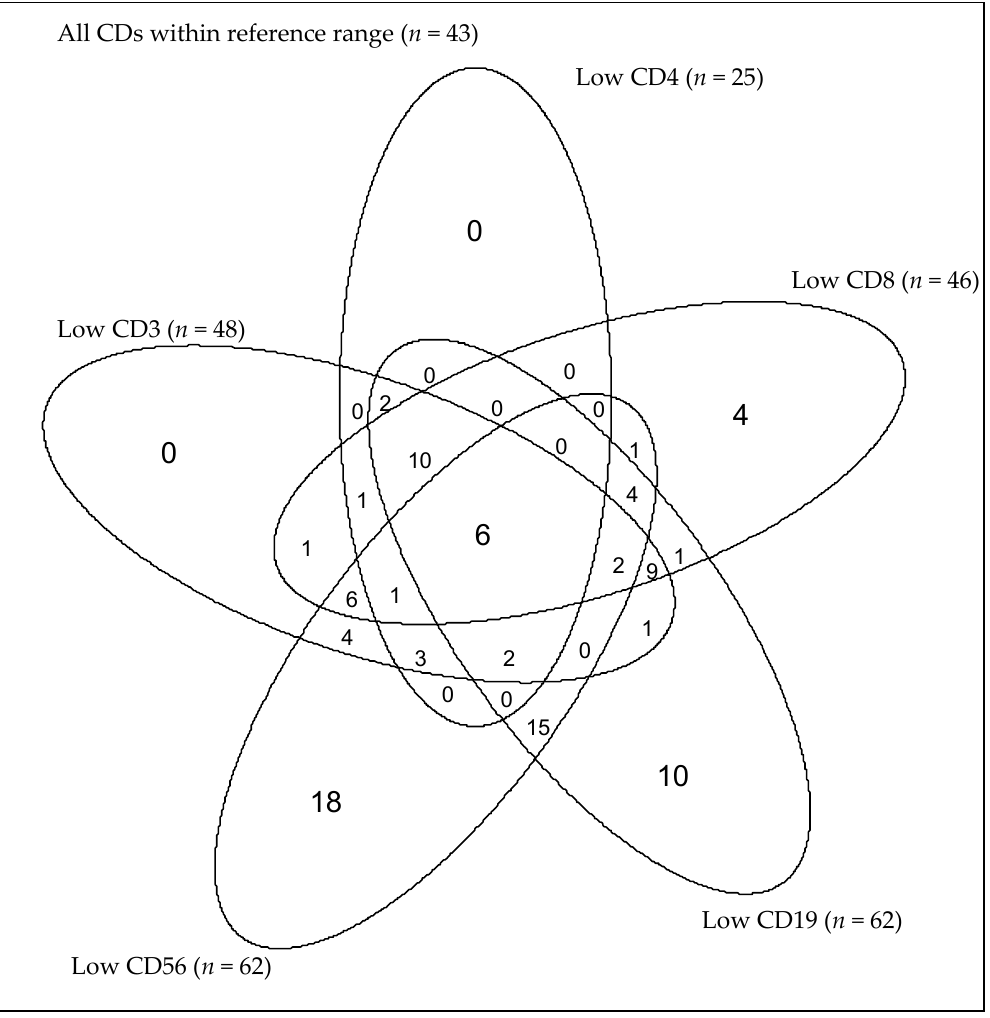
Figure 2. A Venn-diagram showing the distribution of all of the five CDs among the 144 patients. Six (4%) patients had lymphopenia in all the five CDs. Eighteen (13%), 10 (7%), and 15 (10%) patients had isolated CD56, CD19, and both CD56 and CD19 lymphopenia, respectively. Four (3%) patients had isolated CD8 lymphopenia. No patient had an isolated low CD4 or low CD3 count.